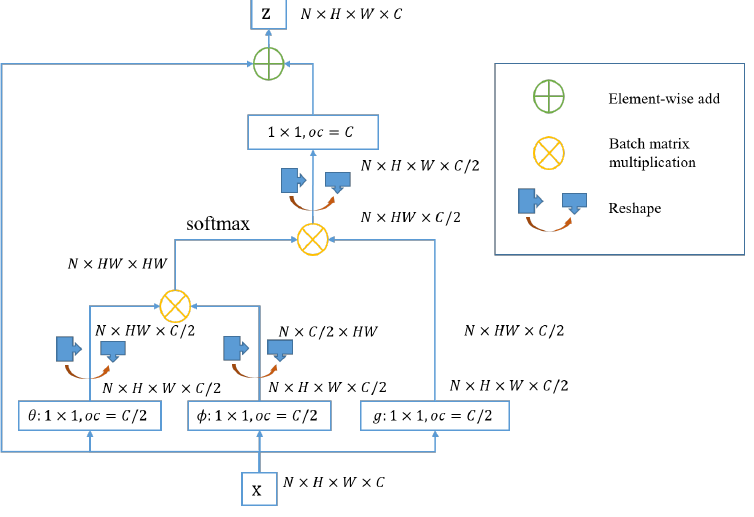
Figure 2. The structure of the non-local